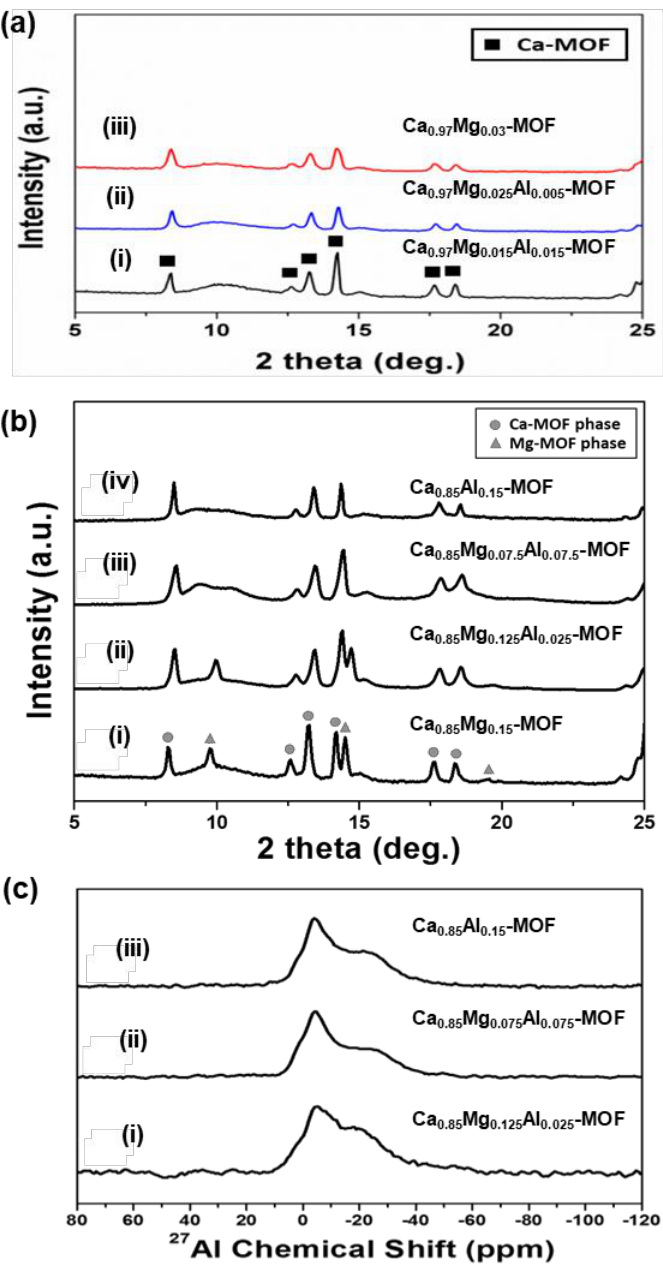
Figure 6. ( a ) XRD patterns of (i) Ca 0.97 Mg 0.03 -MOF, (ii) Ca 0.97 Mg 0.025 Al 0.005 -MOF, (iii) Ca 0.97 Mg 0.015 Al 0.015 - MOF. ( b ) XRD patterns of (i) Ca 0.85 Mg 0.15 -MOF, (ii) Ca 0.85 Mg 0.125 Al 0.025 -MOF, (iii) Ca 0.85 Mg 0.07.5 Al 0.07.5 - MOF, (iv) Ca 0.85 Al 0.15 -MOF. ( c ) 27 Al NMR results of (i) Ca 0.85 Mg 0.125 Al 0.025 -MOF, (ii) Ca 0.85 Mg 0.075 Al 0.075 - MOF, (iii) Ca 0.85 Al 0.15